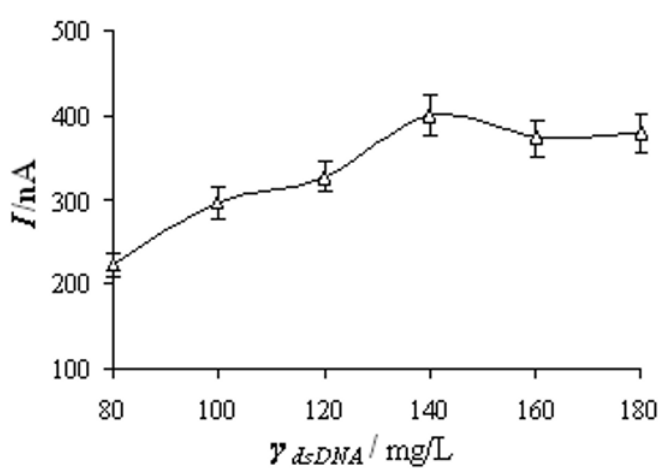
Figure 4. Effect of the dsDNA concentration ( γ